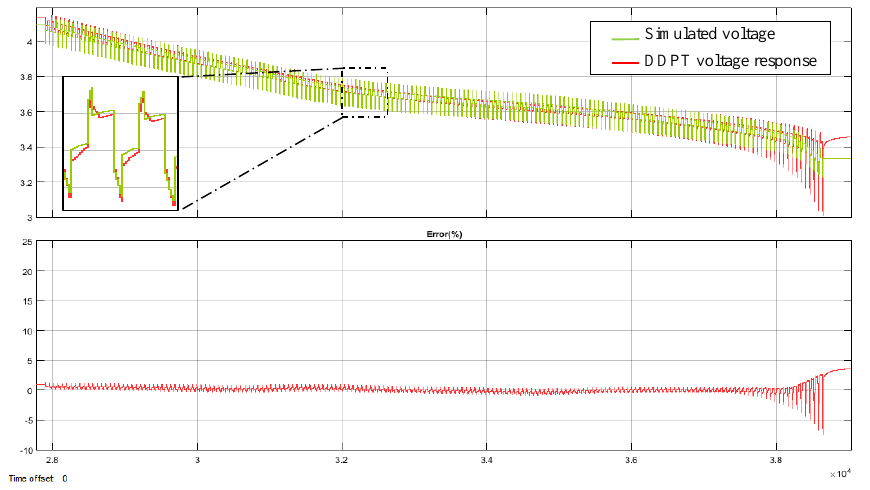
Figure 7. Schematic of the Simulink battery model.